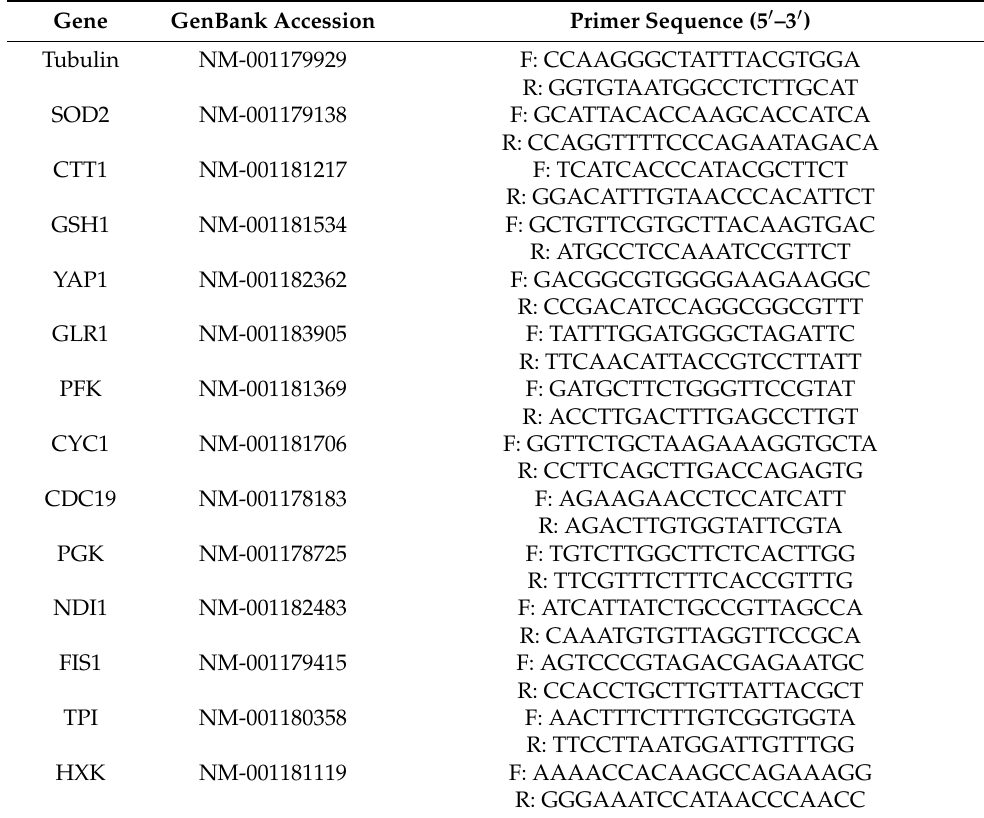
Table 1. Primer sequences for